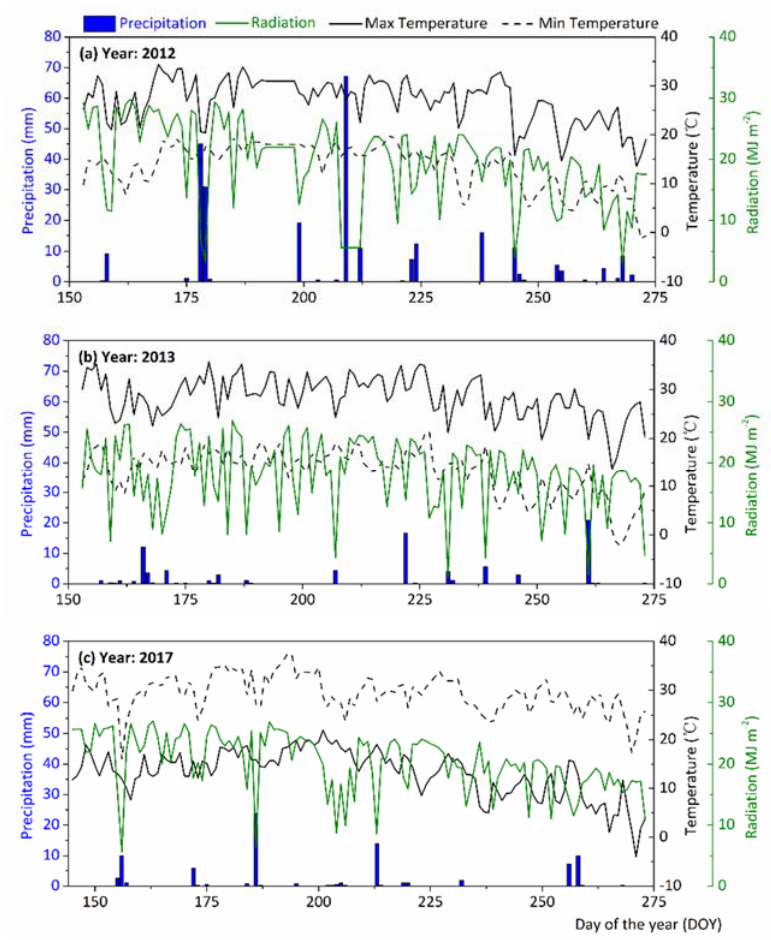
Figure 2. Basic climate data during sunflower growth periods in 2012 ( a ), 2013 ( b ) and 2017 ( c ). In each micro ‐ plot, leaf area was measured on 22 July, 2 August, 9 August, and 20 August in 2012 and on 30 June, 10 July, 24 July, 14 August, 21 August, and 7 September in 2013 using a tape for the length (L) and width (W) of each leaf. The leaf area index (LAI) was calculated as 0.6564 × L × W [50]. After harvesting, air ‐ dried seed yields (<8% moisture) from each micro ‐ plot were weighted. More details about the experiments can be found in our previous publications [18,20]. The initial soil salt and moisture contents differed among micro ‐ plots, and salt and moisture contents varied at different depths in the same micro ‐ plot. Because our study focused on the effects of complex environmental stresses on sunflower growth, the LAI data and seed yield observations from 14 micro ‐ plots with relatively large heterogeneous distributions of initial salt and moisture contents were selected as the data source for this study. Using 2012 as a reference, the maximum and minimum moisture contents were 0.592 cm 3 /cm 3 and 0.073 cm 3 /cm 3 , respectively; the maximum and minimum soil salt contents (measured as saturated electrical conductivity, EC e ) were 1.024 dS/m and 54.982 dS/m, respectively. Details of the soil physical properties and initial moisture and salt contents are shown in Tables 3 and 4, respectively.